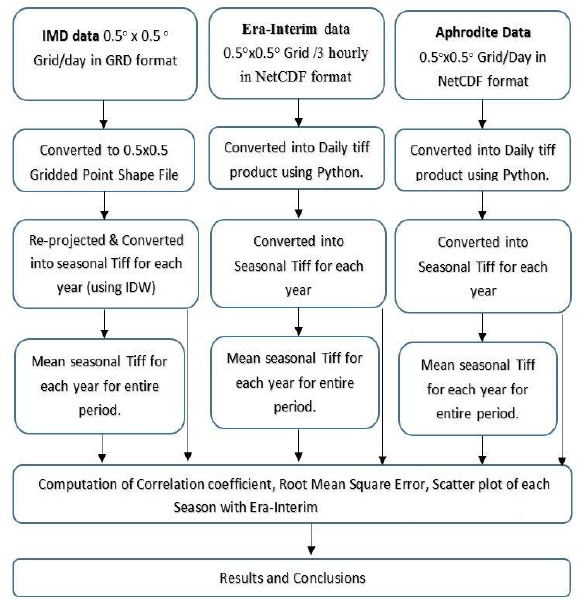
Figure 2. Methodology Flowchart